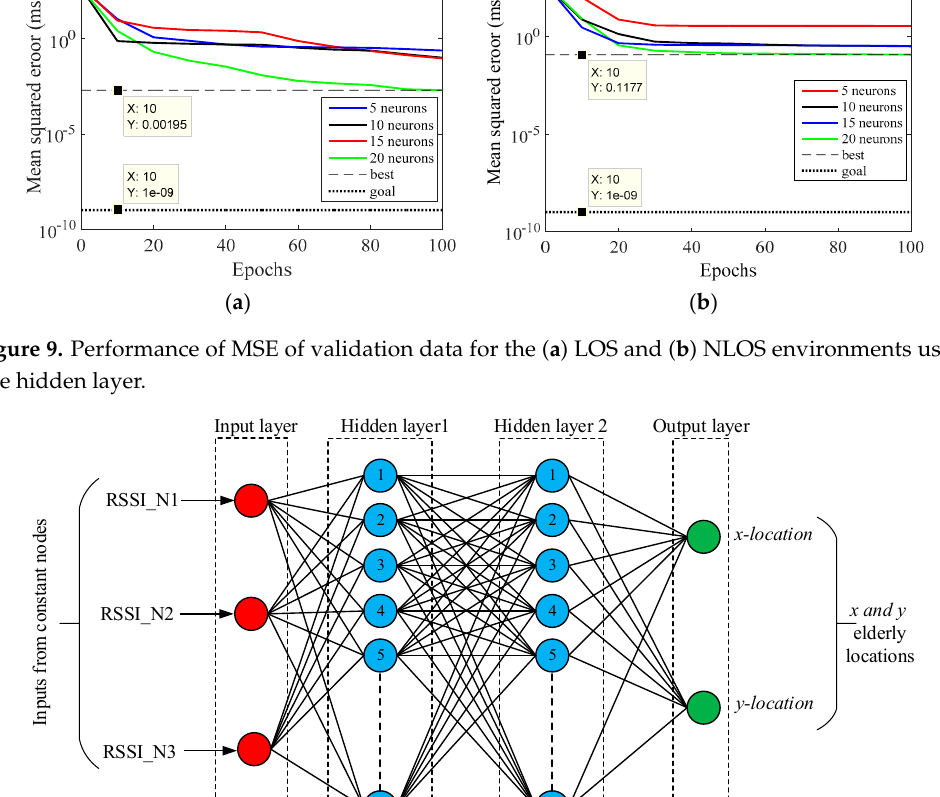
Figure 10. Architecture of adopted ANN.